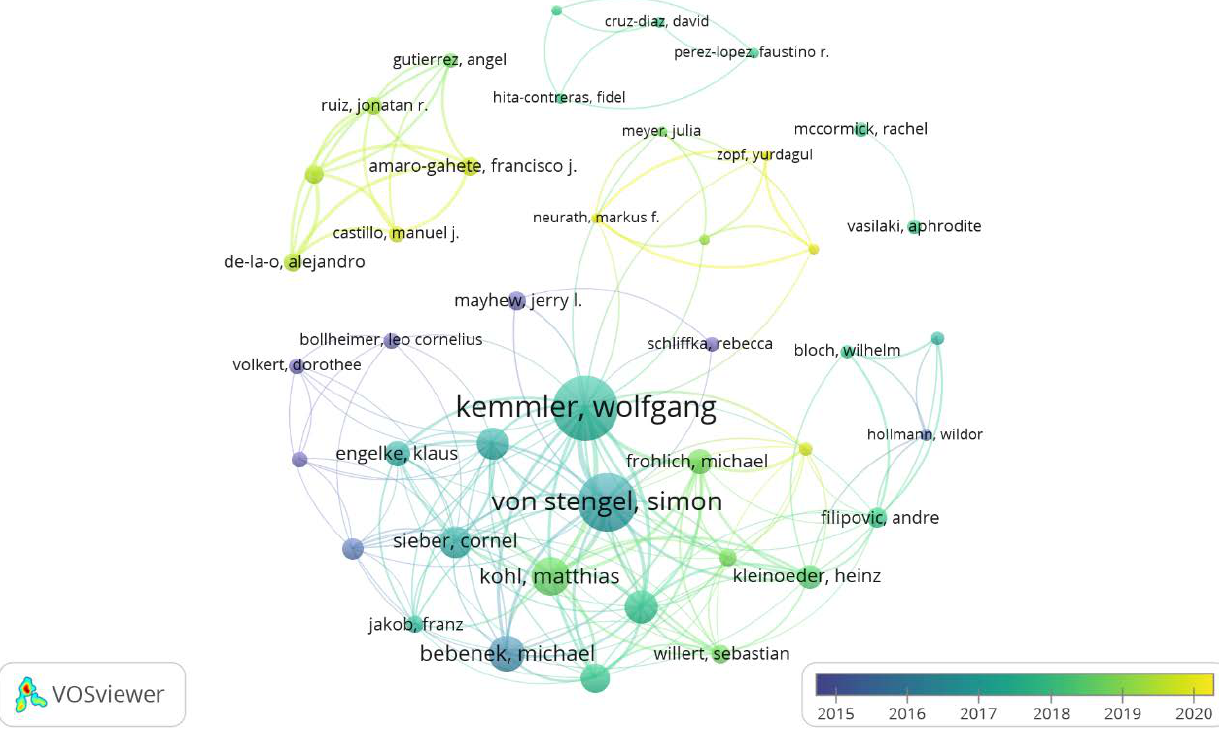
Figure 8. Graph with the most repeated keywords plus on WB-EMS. 4. Discussion